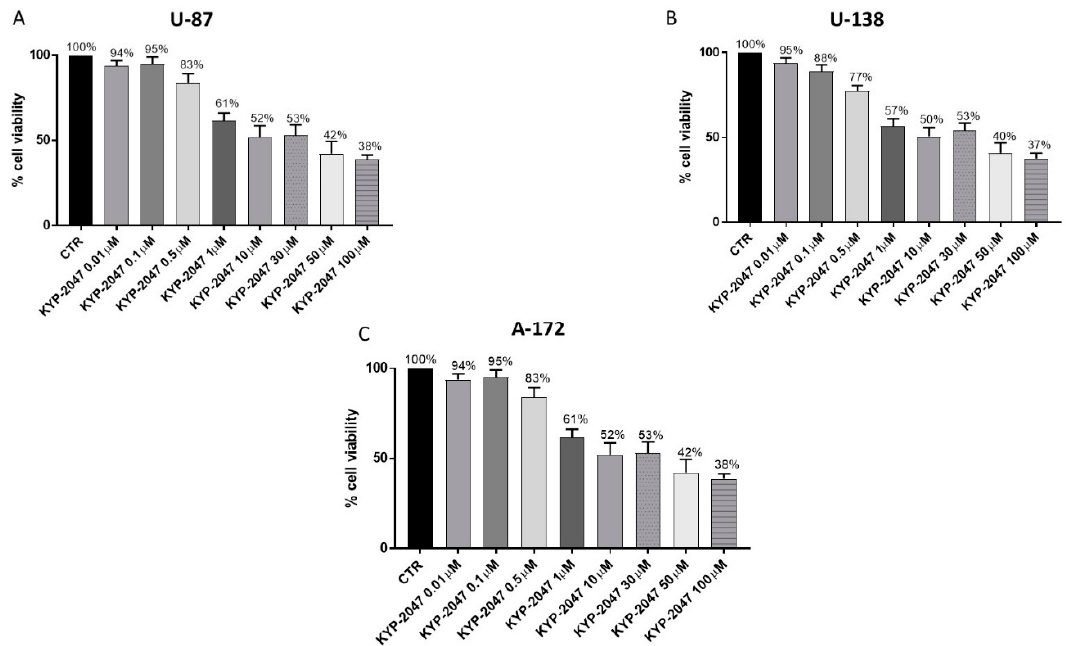
Figure 7. Effect of KYP-2047 on U-87, U-138 and A-172 cell viability. Cell viability was evaluated using MTT assay 24 h after KYP-2047 treatment at the concentrations of 0.01 µM, 0.1 µM, 0.5 µM, 1 µM, 10 µM, 30 µM, 50 µM and 100 µM. U-87, U-138 and A-172 cells showed a similar decrease of cell viability following KYP-2047 treatment in a concentration-dependent manner ( A – C ). Data are representative of at least three independent experiments.